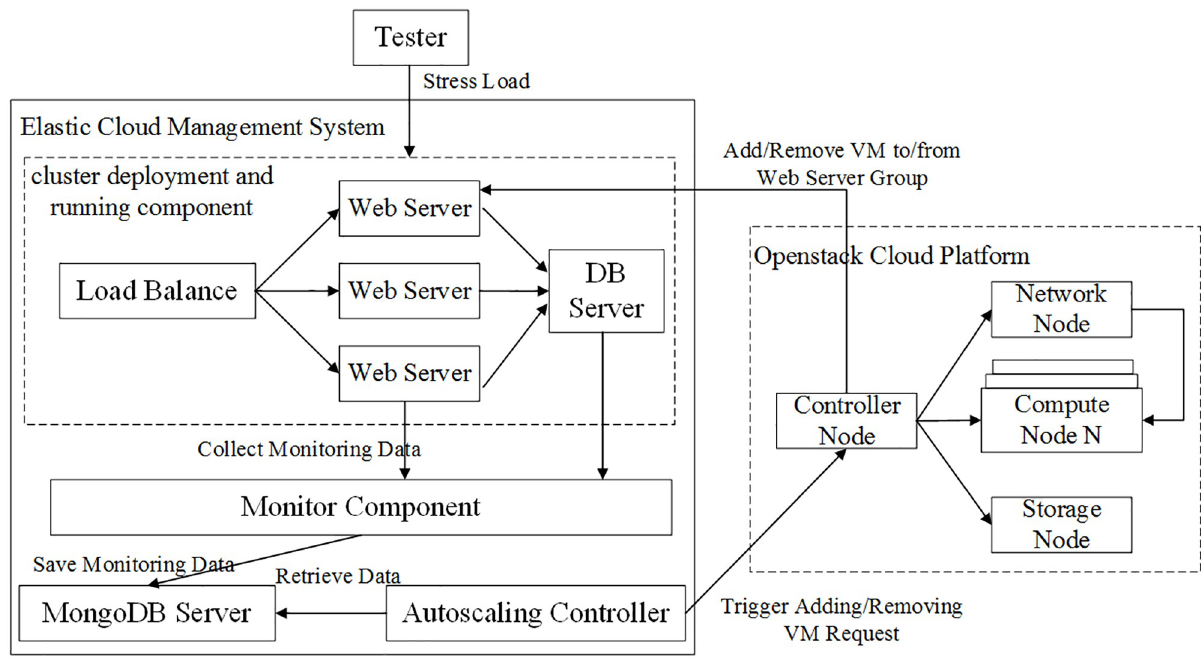
Fig 13. An elastic cloud management system based on an Openstack cloud platform.